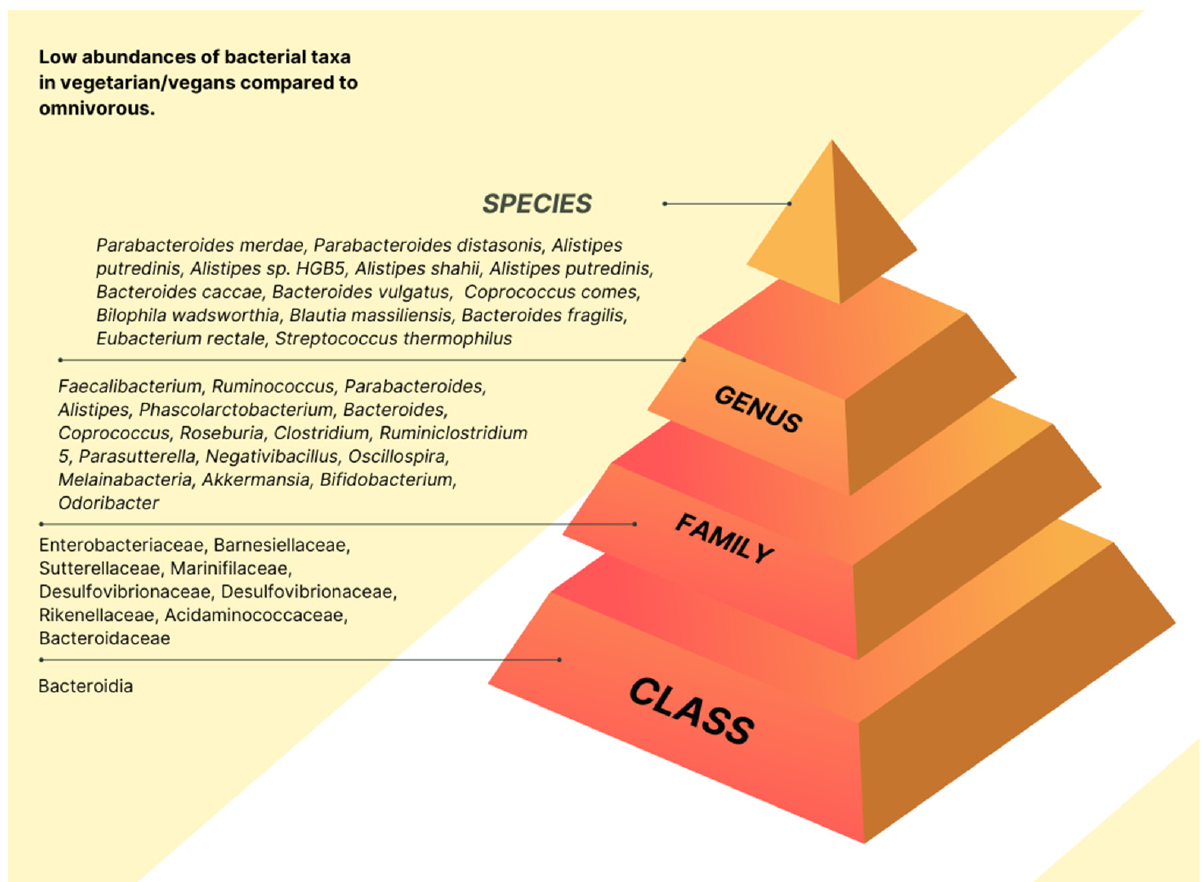
Figure 2. Higher abundances of bacterial taxa in vegetarian/vegan intervention diets. The figure was created and edited from the images available on Canva.com using a Pro Content License.